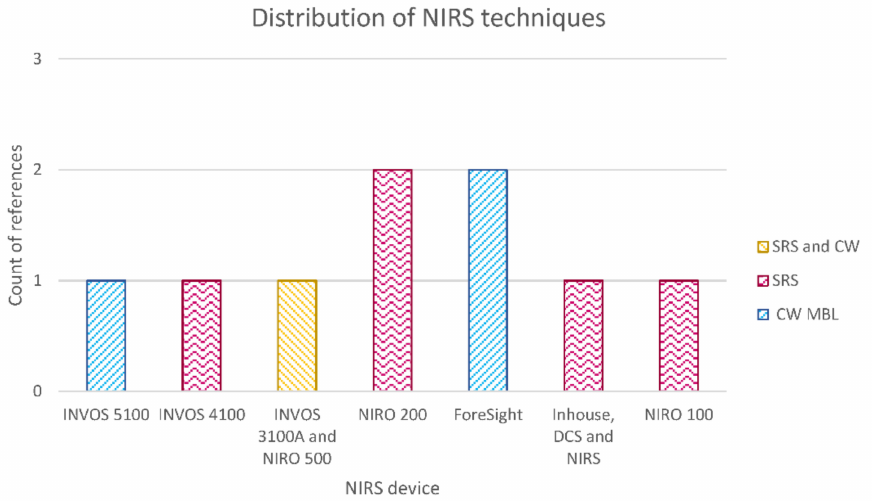
Figure 13. Distribution of NIRS techniques used for autoregulation monitoring in TBI patients.